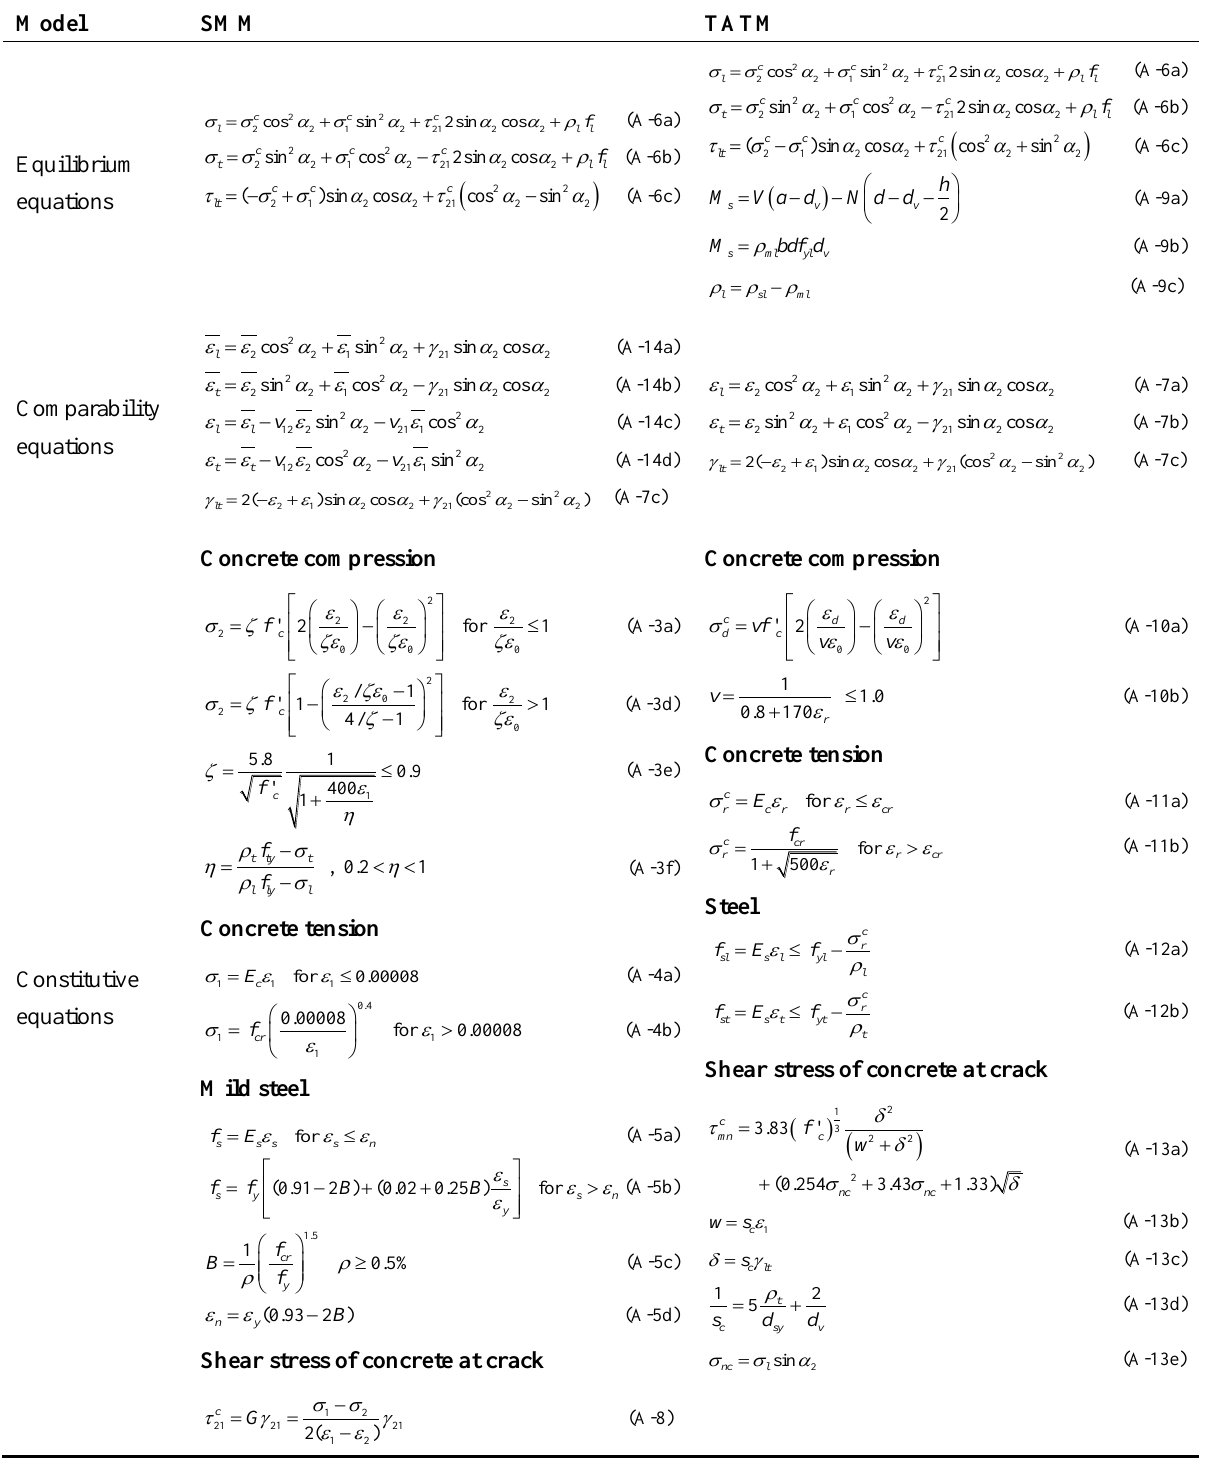
Table A-2. Equations in TATM and